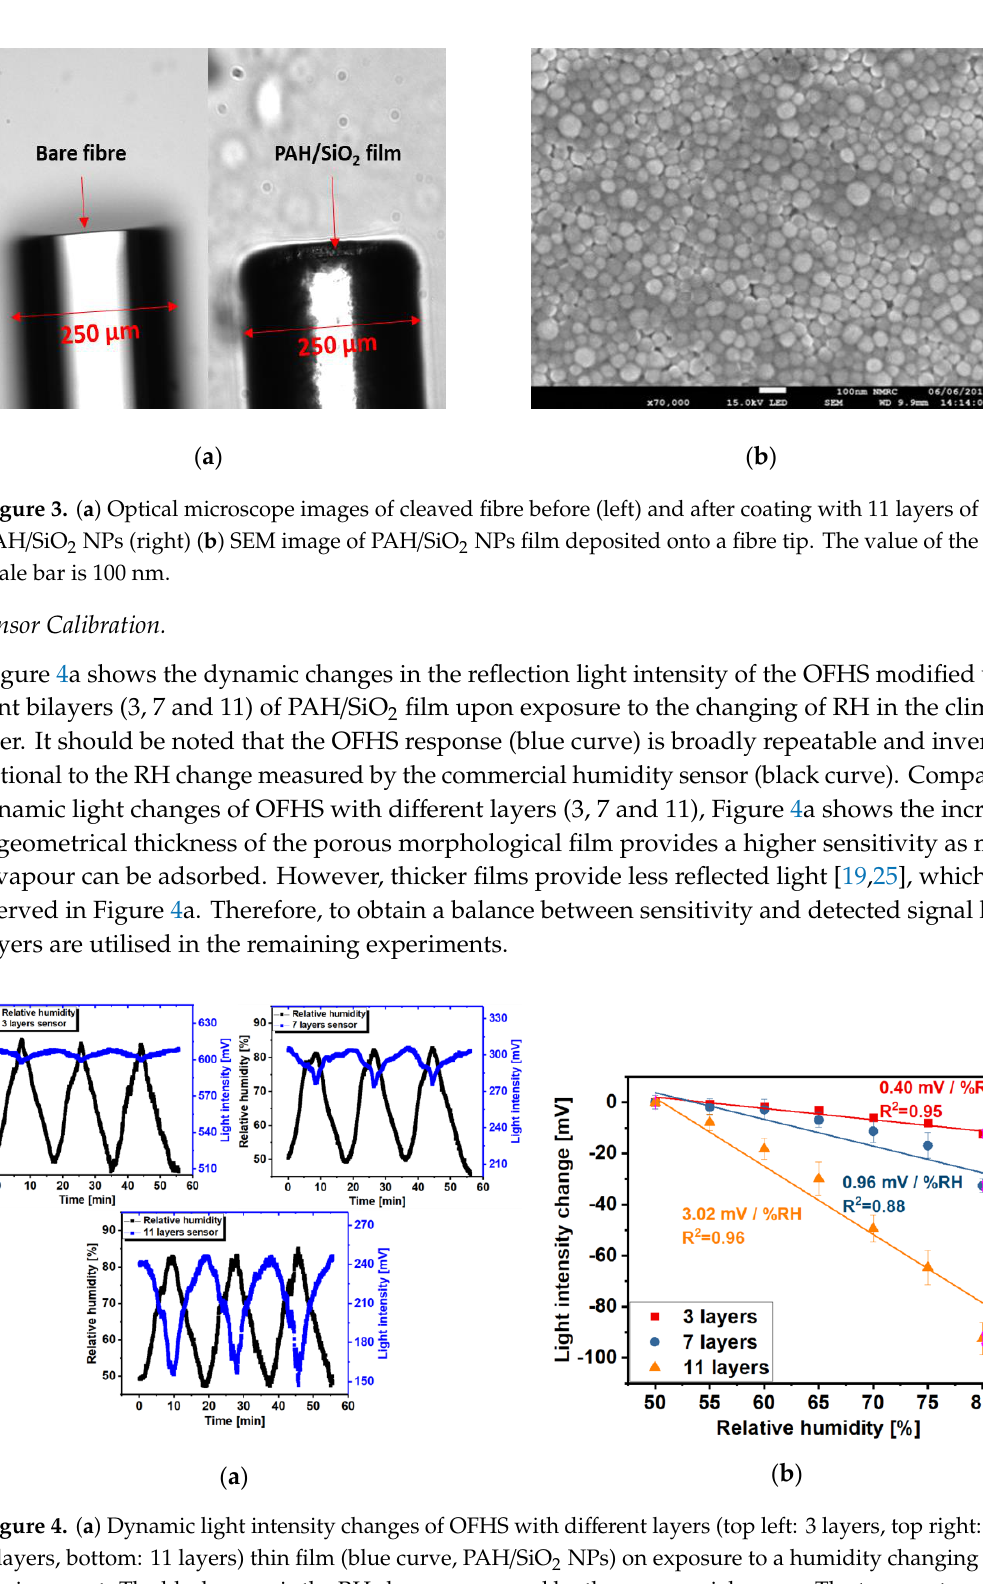
Figure 4. ( a ) Dynamic light intensity changes of OFHS with different layers (top left: 3 layers, top right: 7 layers, bottom: 11 layers) thin film (blue curve, PAH/SiO 2 NPs) on exposure to a humidity changing environment. The black curve is the RH change measured by the commercial sensor. The temperature is fixed at 30 °C in the climatic chamber for the duration of the experiment. ( b ) Calibration curves for OFHSs with 3, 7 and 11 layers thin film represent the sensitivity for each case (error bars represent the standard deviation of three repeat cycles). For the purpose of comparison, the Y-axis in the calibration curve shows the differences in reflected light intensity relative to the left experimental value. Figure 4b shows the calibration curves for RH measurements with OFHS with 3, 7 and 11 layers of PAH/SiO 2 thin film. For all sensors, the light intensity change was observed to exhibit an approximately linear dependence on the change of RH (50 – 80 %). It can be observed that the greater